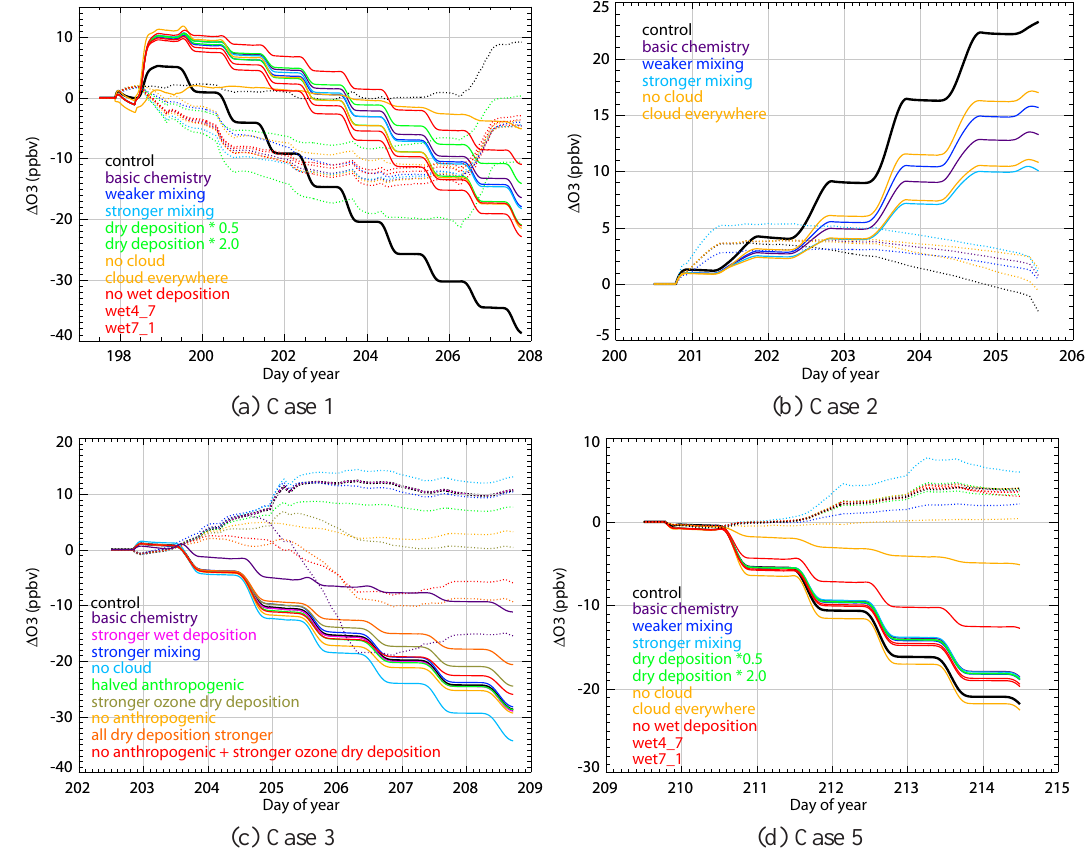
Fig. 9. 1 O 3 partitioned by process and accumulated along the reference trajectory, as Fig. 5. Solid lines are from the accumulation of Fig. 9. ∆O 3 partitionedbyprocessandaccumulatedalongthereferencetrajectory,asforFig. 5. Solid tendencies from chemistry ( 1 O 3chem ), and dotted lines are from the accumulation of tendencies from physical processes ( 1 O 3phys ). linesarefromtheaccumulationoftendenciesfromchemistry( ∆ O 3 chem ),anddottedlinesarefromthe accumulationoftendenciesfromphysicalprocesses( ∆ O 3 phys ). as compensating effects make O 3 mixing ratios relatively in- sensitive to small changes to the model set